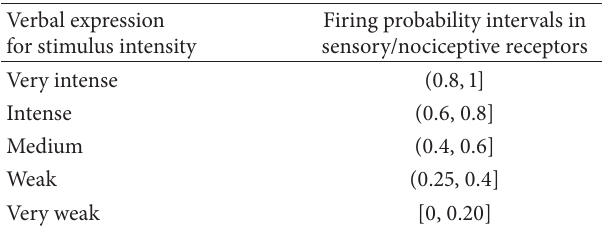
Table 2: Stimulus intensity and firing probability of sensory/noci- ceptive receptors. For the qualitative purposes of our research, we elaborate a table that arbitrarily associate a verbal expression describing the intensity of a sensory/nociceptive stimulus with a firing probability